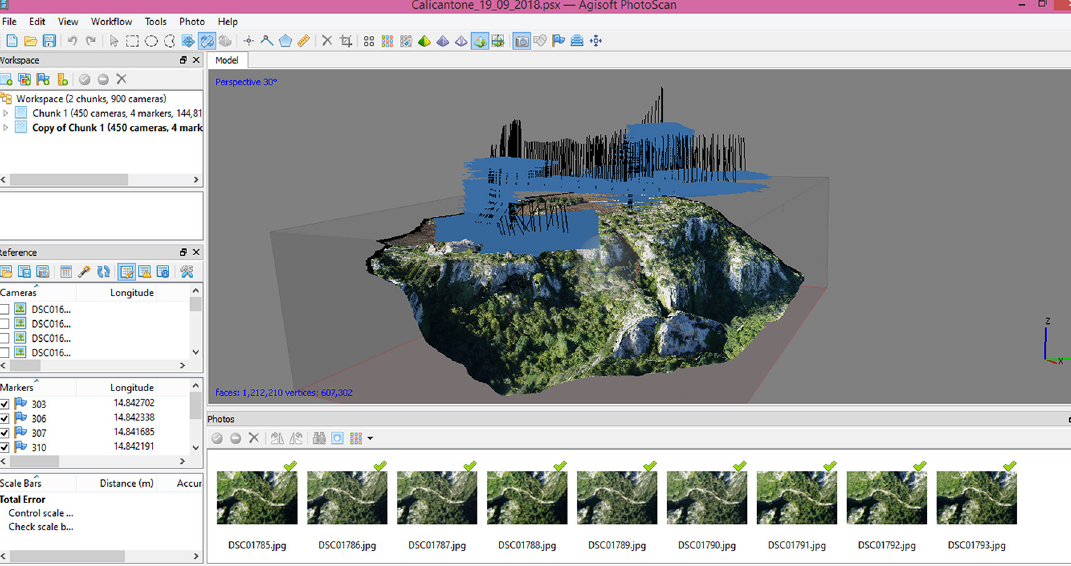
Figure 9. Photoscan Professional 1.2 postprocessing of the UAV and GPS